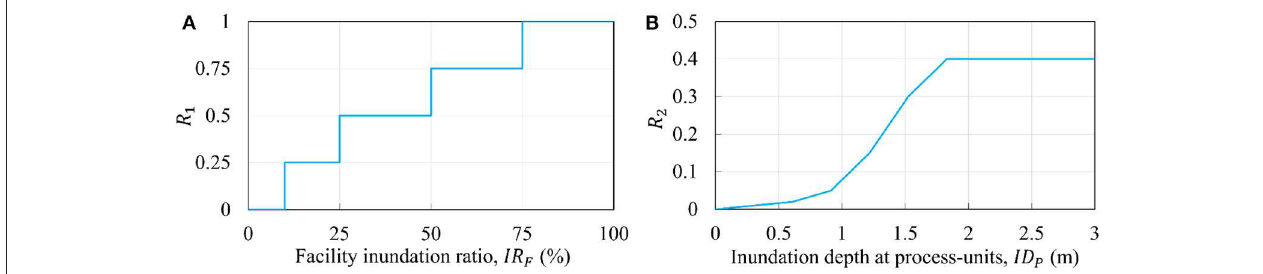
FIGURE 3 | Function to (A) determine land value loss ratio ( R 1 ) [adopted from (Burleson, 2015)]; and (B) process-unit damage parameter ( R 2 ) [adopted from (Federal Emergency Management Agency (FEMA) Mitigation Division,